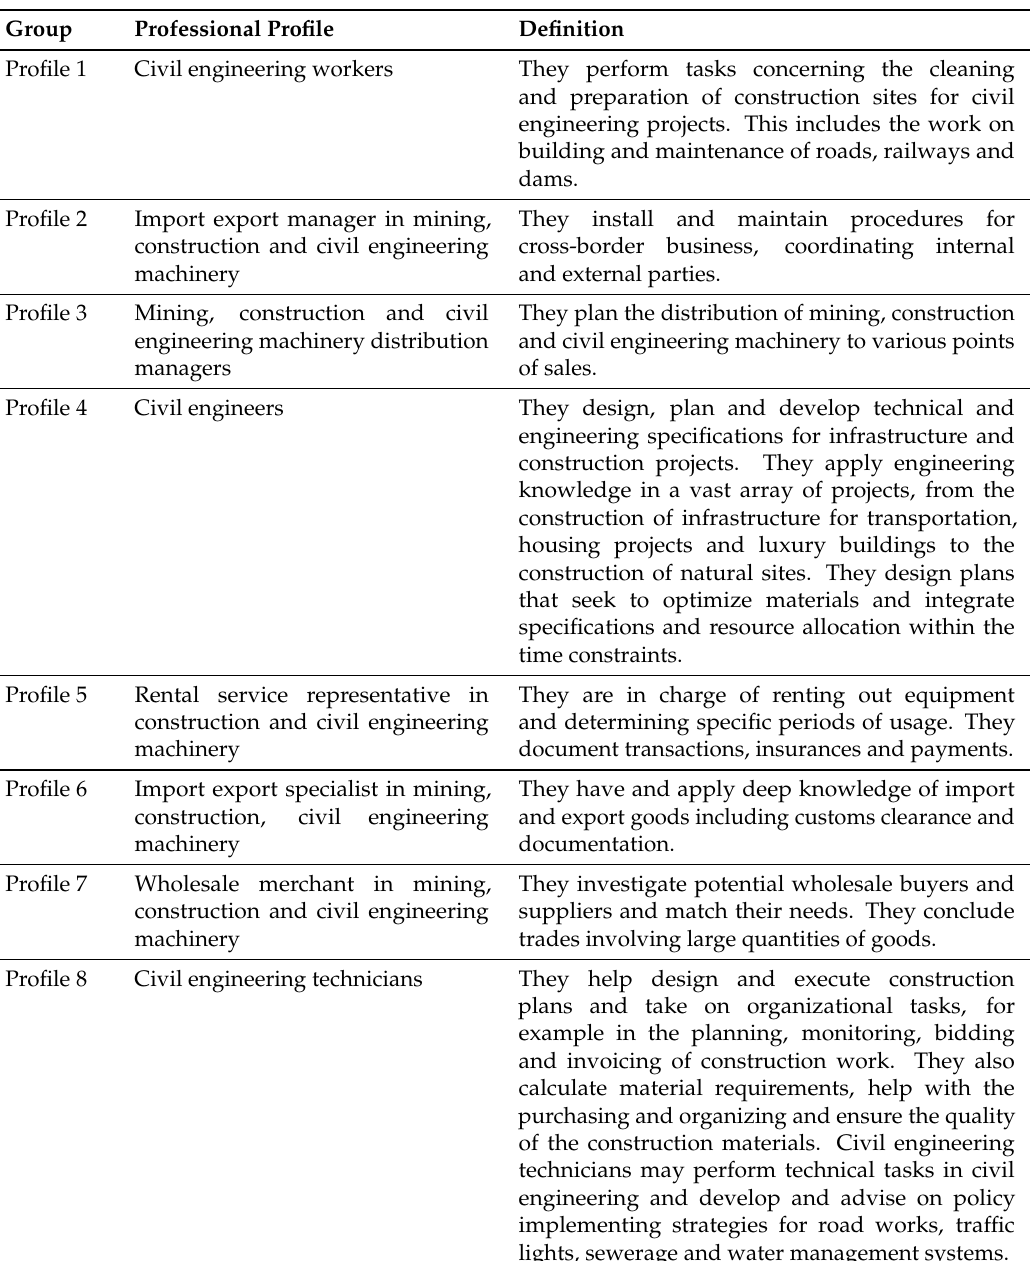
Table 1. Professional profiles related to civil